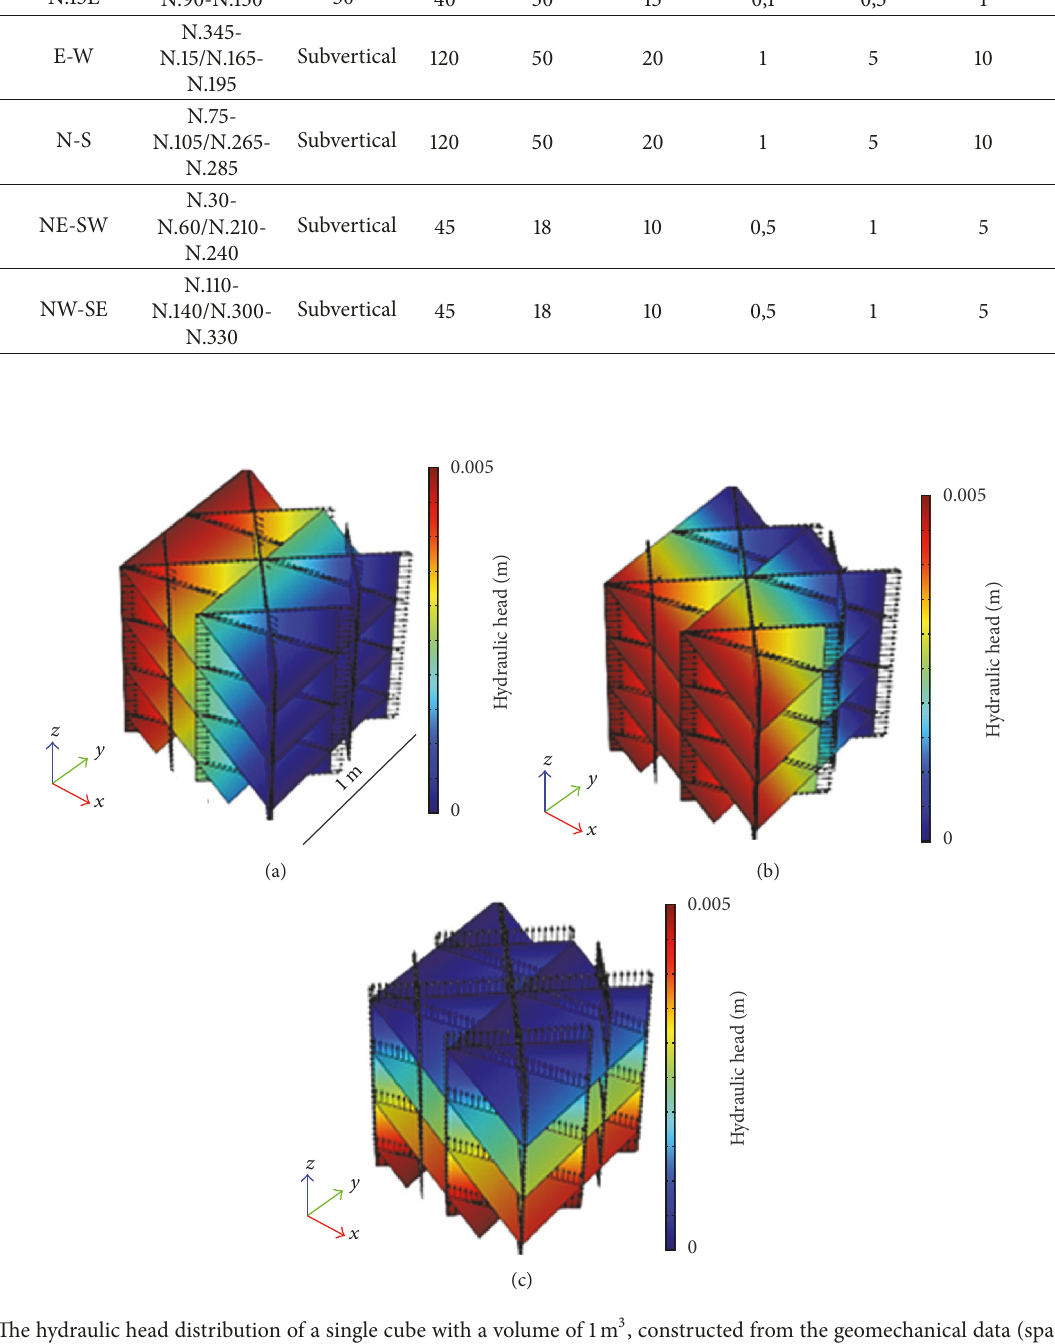
Figure 5: The hydraulic head distribution of a single cube with a volume of 1m 3 , constructed from the geomechanical data (spacing set 1). The regional gradient has been applied along the 𝑥 -axis (a), the 𝑦 -axis (b), and the 𝑧 -axis (c). The black arrows indicate the flow direction along the